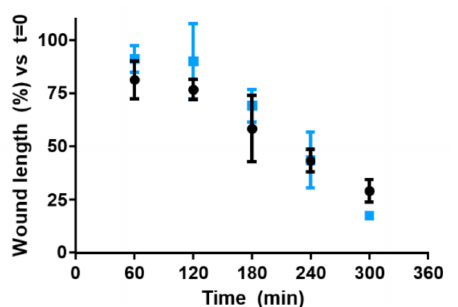
Figure 11. Width of wound gap though time, when compared with t = 0 (maximum width). Black series: control; Blue series: cells incubated with H-Phe- ∆ Phe-OH ( 3 ) at 100 µ